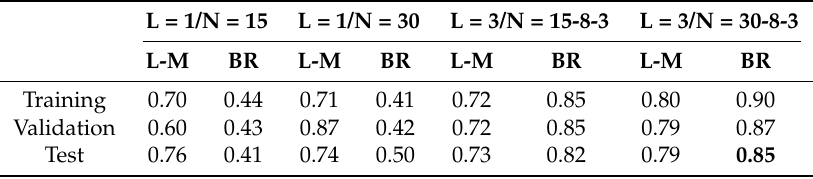
Table 5. Classification accuracy of different ANN